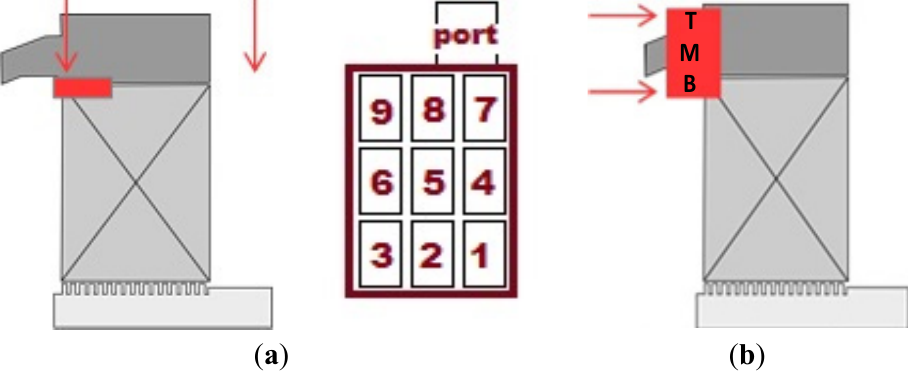
Figure 13. Schematic representation of the chamber with experimental test sections. ( a ) = top section of the checker zone where the nine control cells are put in evidence; ( b ) = cross section of the port where the measuring points defined as bottom (B), middle (M) and top (T) are